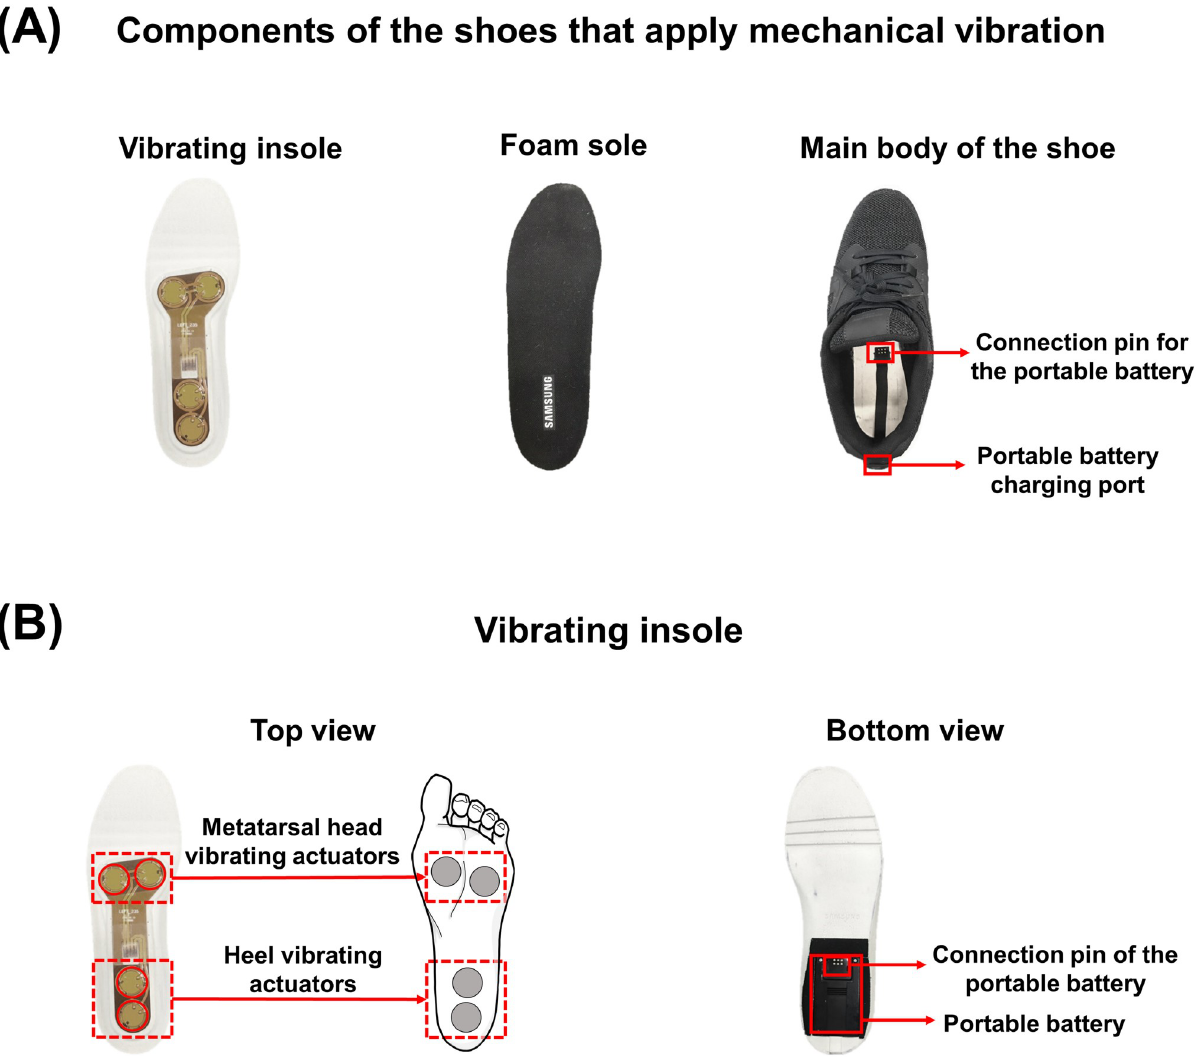
Fig 1. Overview of the components of the shoes and vibrating insole that apply mechanical vibration. (A) The components of the shoes that apply the mechanical vibration to the soles of the feet. The main components are the vibrating insoles that contains the actuators that deliver mechanical vibration, a foam sole placed on top of the insoles to act as a shock absorber, and main body of the shoe that contains the connection pin and charging port to recharge battery. (B) The top and bottom view of the vibrating insoles. The top view shows the position of pair of actuators used to deliver the vibration to the metatarsal head (front actuators) and heel (rear actuators). The amplitude of the vibration is controlled independently for the two pairs of actuators, which allows users to apply the vibration to different areas of the foot with different amplitudes. The bottom view shows the position of the portable battery and the connection pin for the charging port of the